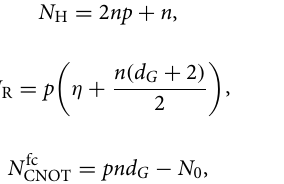
Figure 1. Hardware connectivity graphs for ( a ) heavy-hexagon, d H d H 4 , and ( d ) triangle, d H =